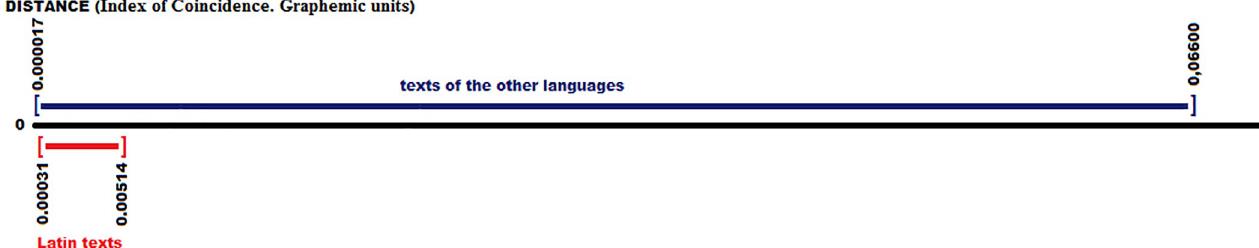
Fig 4. Index of Coincidence of the texts in Latin (graphemic units) (red) versus the rest of the texts